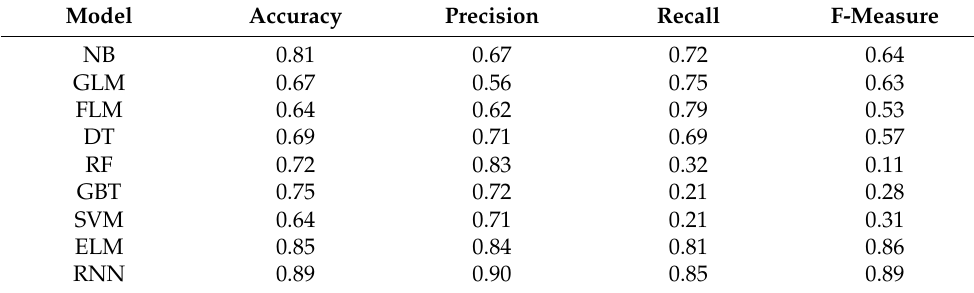
Table 9. Performance of the algorithms on the data set extracted from Twitter.